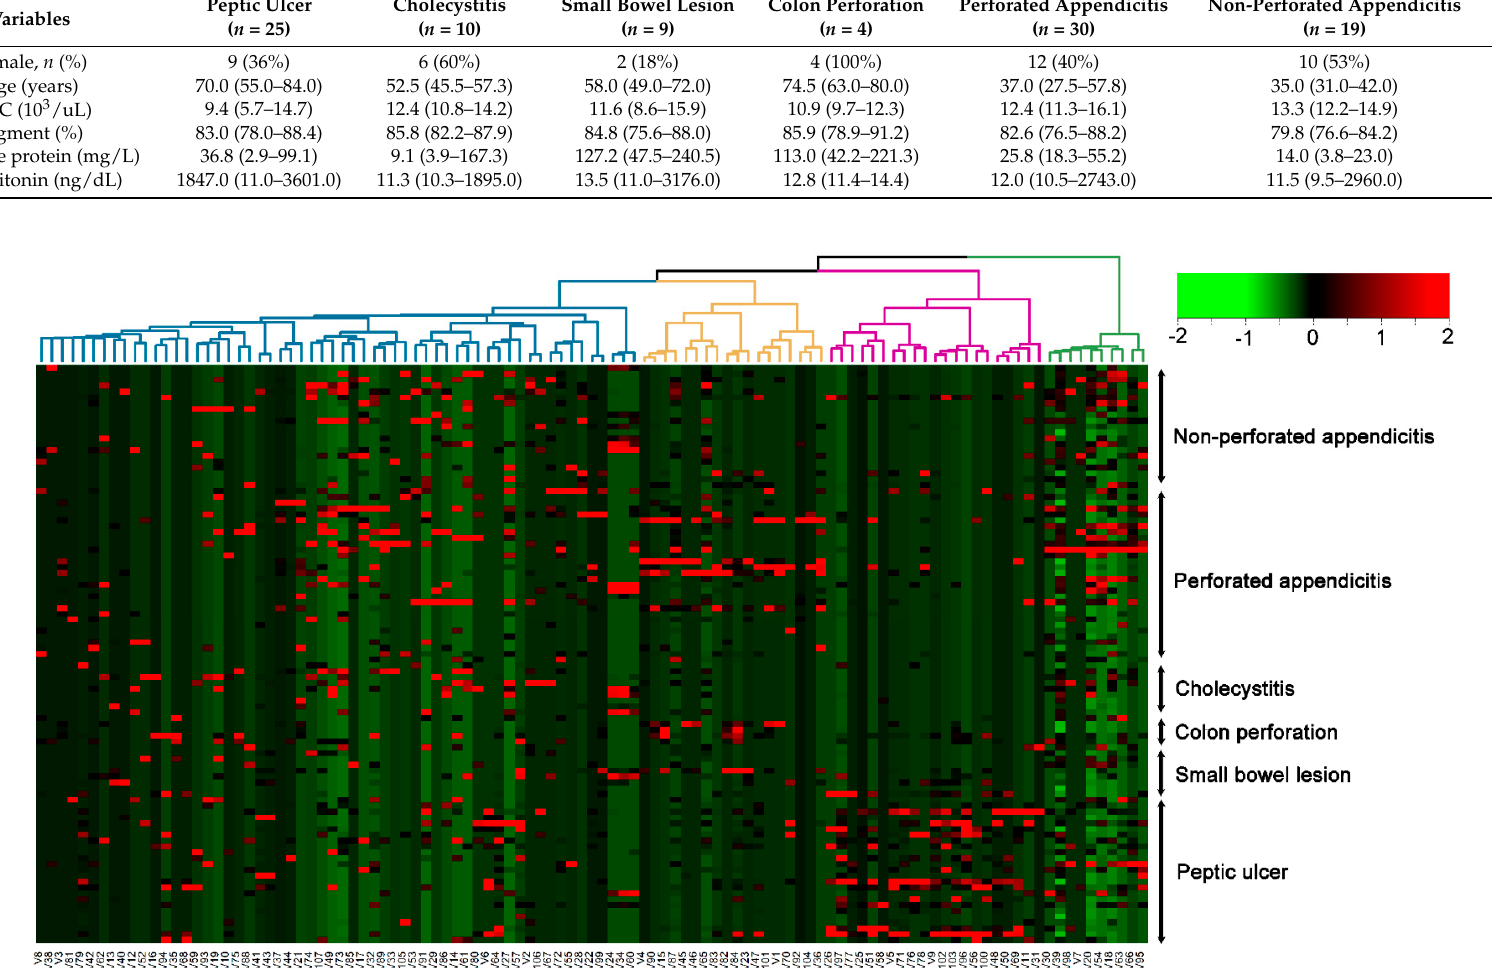
Figure 1. Hierarchical clustering of the 107 bacterial taxa identified from the ascites of these patients from metagenome analysis.